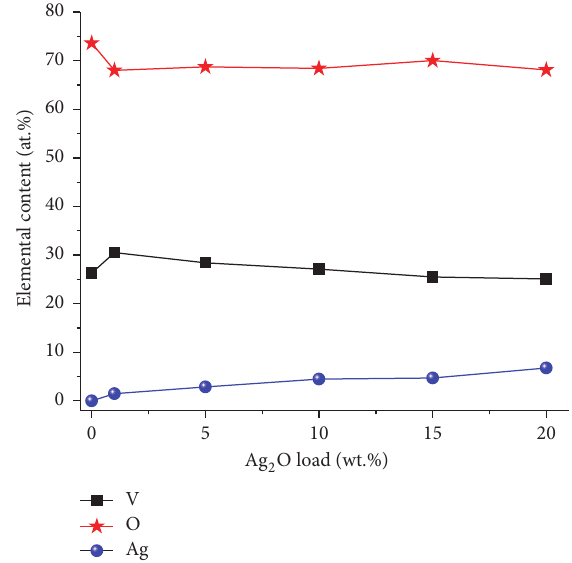
Figure 8: Elemental atomic contents for the V 2 O 5 - x Ag photocata-